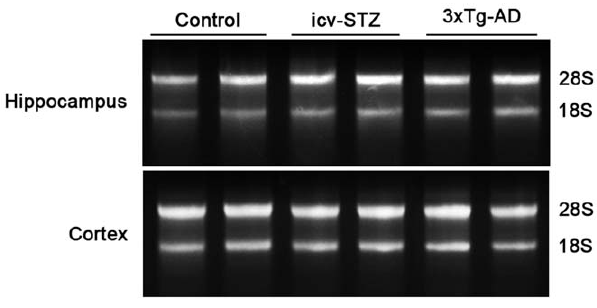
Figure 1. RNA integrity. Total RNA samples (1.5 m g/lane) extracted from mouse brains were separated in 1.2% native agarose gels and visualized under ultraviolet